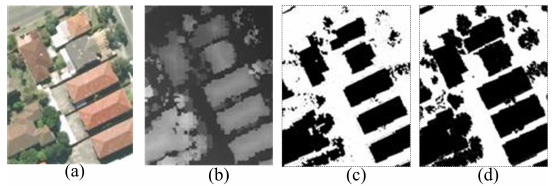
Figure 2: (a) Image of a test scene, (b) corresponding LIDAR data (in gray-scale), (c) primary mask and (d) secondary mask.